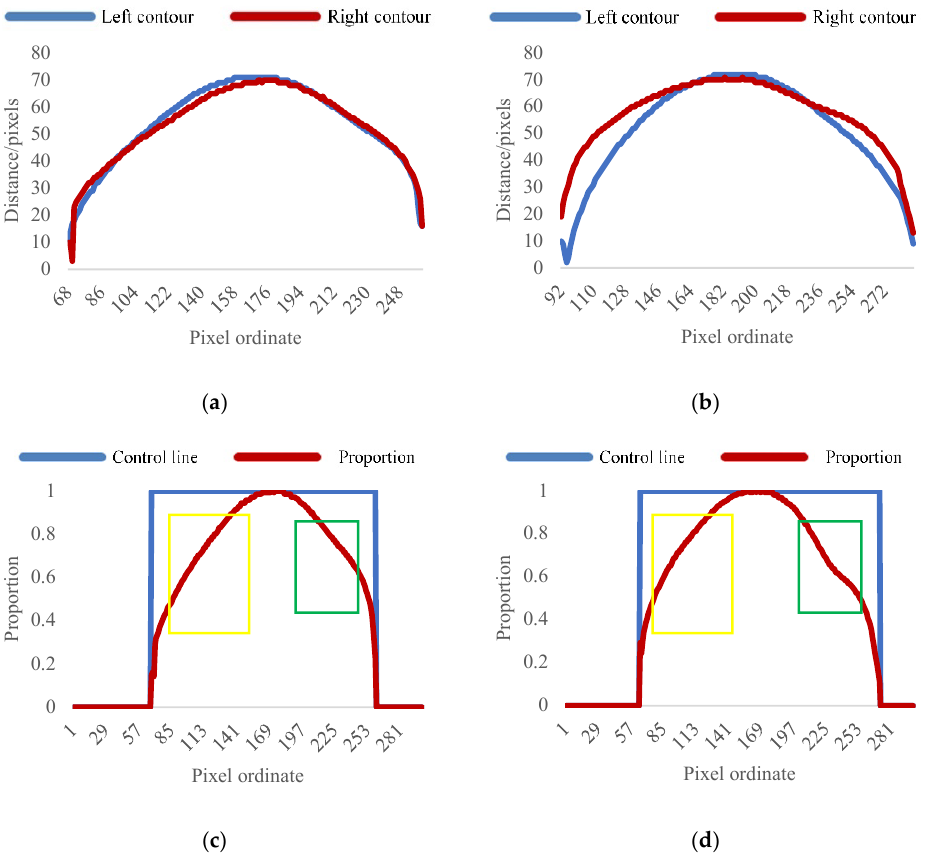
Figure 16. Comparison of pear shape features: ( a ) Symmetry feature of standard shape. ( b ) Symmetry feature of eccentric shape. ( c ) Quasi-rectangularity feature of standard shape. ( d ) Quasi-rectangularity feature of apical shape.